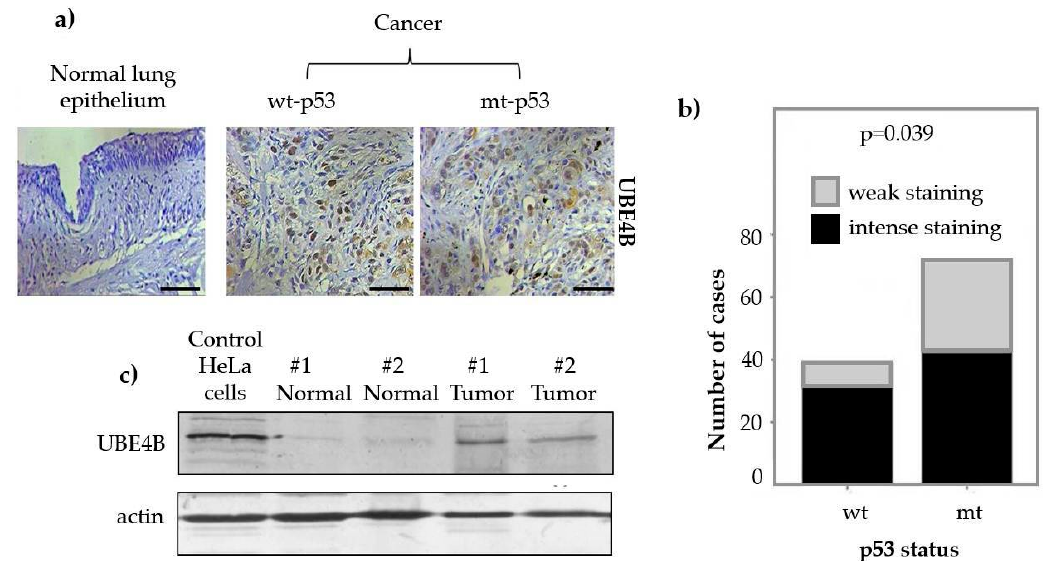
Figure 3. Immunohistochemistry (IHC) and Western Blot (WB) analysis of UBE4B expression in lung tissue samples. ( a ) Representative images of UBE4B IHC in normal versus lung tumor tissues with either wild type or mutant p53. Regardless of p53 status, UBE4B is overexpressed in tumor samples compared with normal ones. Mutant p53 tumor samples show less-intense UBE4B staining than in the corresponding wild type p53 tumor samples. Scale bar: 50 µ m. ( b ) Statistical analysis of UBE4B IHC expression in lung carcinomas with wt-p53 (38 cases) and mut-p53 (70 cases). Wt-p53 tumor cases show a higher ratio of intense versus weak UBE4B staining (0.925) compared with mut-p53 tumor cases (0.6). ( c ) Representative immunoblots of two pairs (normal versus tumor) of lung tissue samples where UBE4B is increased in tumors with respect to their normal counterparts. HeLa cells were used as positive control.